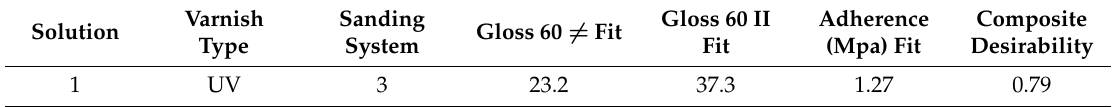
Table 6. Response optimization for adherence and gloss as a function of sanding system and varnish type.